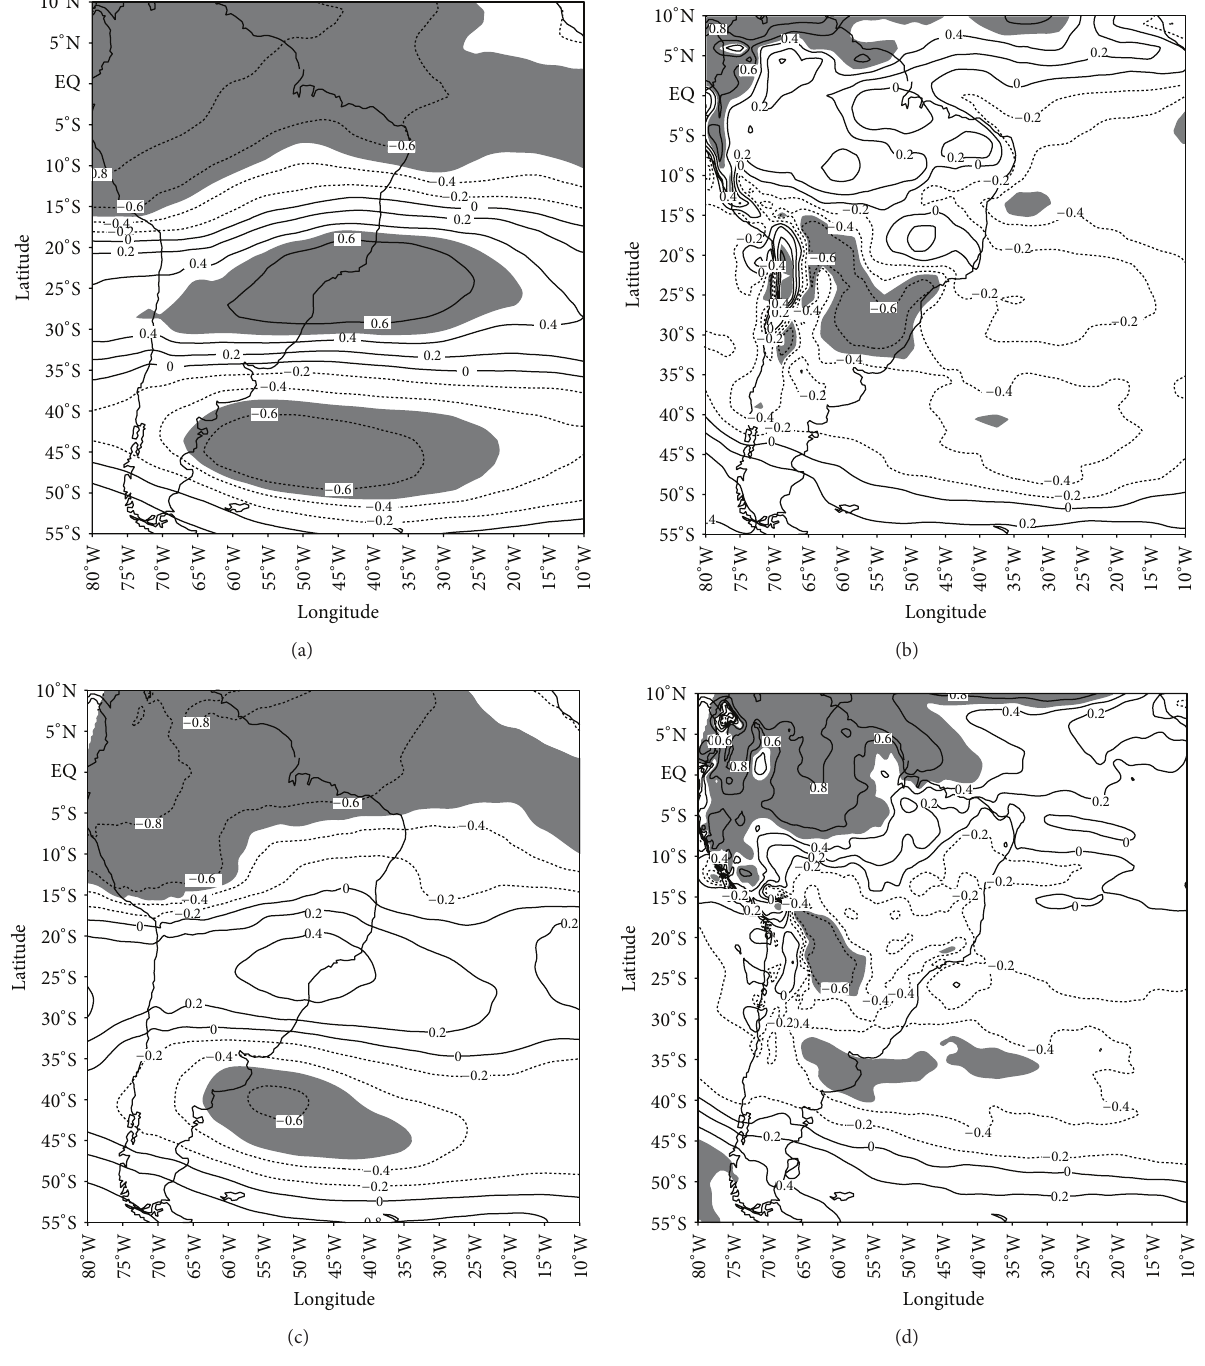
Figure 8: Correlation between the HCSA annual intensity index and the annual mean zonal wind (ms −1 ) in the period 1996–2011 based on the Era-Interim reanalysis at (a) 200 hPa and (b) 850 hPa and RegCM4 simulation at (c) 200 hPa and (d) 850 hPa. Contour intervals are 0.2 and values above 0.5 are shaded and are statistically significant at 95% confidence level. For clarity purposes, it should be noted that the HCSA annual intensity index time series have been multiplied by ( −